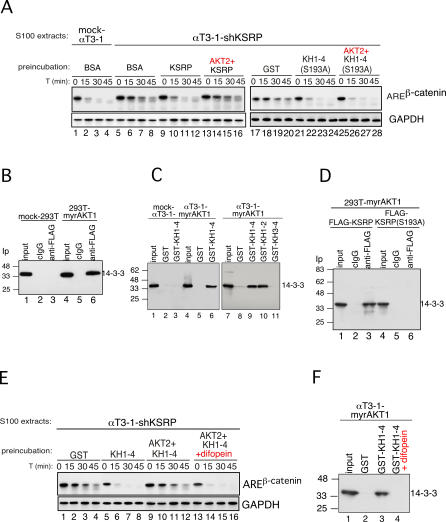
KSRP Phosphorylation by AKT Promotes Its Interaction with 14-3-3 and Affects Its mRNA-Destabilizing Function(A) In vitro RNA degradation assays using S100s from either mock αT3-1 (lanes 1–4) or αT3-1–shKSRP cells (lanes 5–28) preincubated with BSA (lanes 1–8), GST (lanes 17–20), KSRP (30 nM, lanes 9–12), AKT2-phosphorylated KSRP (30 nM, lanes 13–16), KH1-4 (S193A) (30 nM, lanes 21–24), or AKT2-phosphorylated KH1-4(S193A) (30 nM, lanes 25–28), respectively. Internally 32P-labeled and capped RNA substrates were added, and their decay was monitored as described above.(B) Coimmunoprecipitation of FLAG-KSRP and endogenous 14-3-3 in 293T cells transiently transfected with FLAG-KSRP and either pCMV empty vector (mock 293T) or pCMV-myrAKT1 (293T-myrAKT1). Cell lysates were immunoprecipitated as indicated and analyzed by immunoblotting using anti–14-3-3 antibody.(C) GST pull-down of endogenous 14-3-3 from total extracts of either mock αT3-1 (lanes 1–3) or αT3-1–myrAKT1 (lanes 4–11) cells using either control GST, GST–KH1-4, or the additional KSRP deletion mutants fused with GST (as indicated, see Figure 4B for a schematic representation of KSRP deletion mutants). Proteins were analyzed by immunoblotting using anti–14-3-3 antibody.(D) Coimmunoprecipitation of either FLAG-KSRP or FLAG-KSRP(S193A) and endogenous 14-3-3 in 293T cells transiently transfected with pCMV-myrAKT1 (293T-myrAKT1) and either FLAG-KSRP or FLAG-KSRP(S193A). Cell lysates were immunoprecipitated as indicated and analyzed by immunoblotting using anti–14-3-3 antibody.(E) In vitro RNA degradation assays using S100s from αT3-1–shKSRP cells pre-incubated with either GST (lanes 1–4), KH1-4 (30 nM, lanes 5–8), AKT2-phosphorylated KH1-4 (30 nM, lanes 9–12), or AKT2-phosphorylated KH1-4 (30 nM) preincubated with difopein (50 nM) (lanes 13–16), respectively. Internally 32P-labeled and capped RNA substrates were added, and their decay monitored was as described above.(F) GST pull-down of endogenous 14-3-3 from total extracts of αT3-1-myrAKT1 cells using either control GST, GST–KH1-4, or GST–KH1-4 preincubated with 50 nM difopein (as indicated). Proteins were analyzed by immunoblotting using anti–14-3-3 antibody.